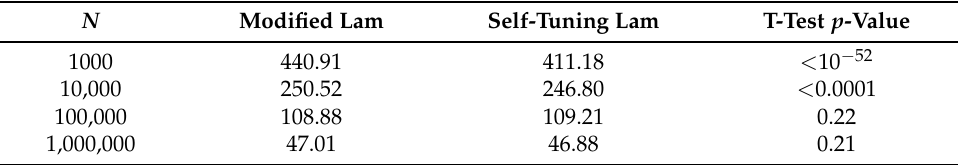
Table 19. Average cost of solution to TSP with 1000 cities distributed within a unit square.